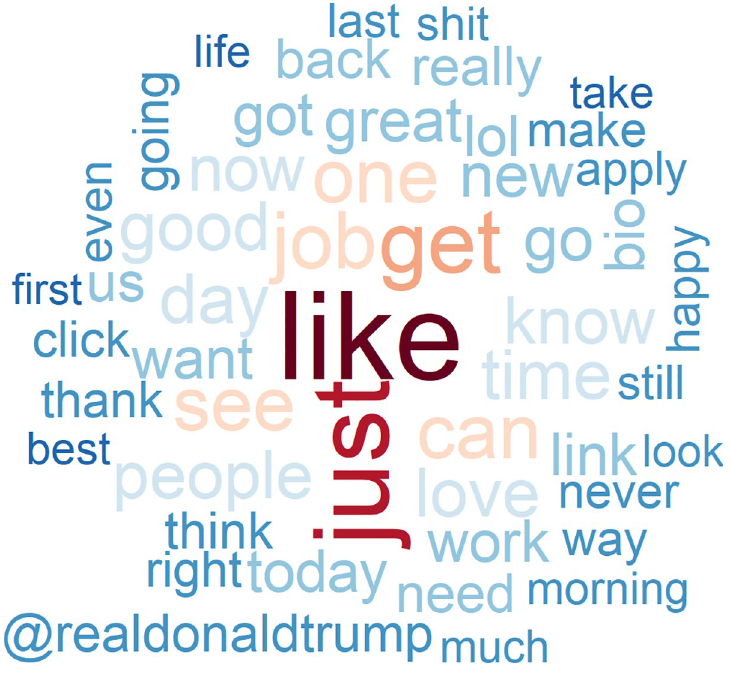
Fig 2. The 50 most-often used words in tweets of the general US Twitter-using population (N = 49,790).